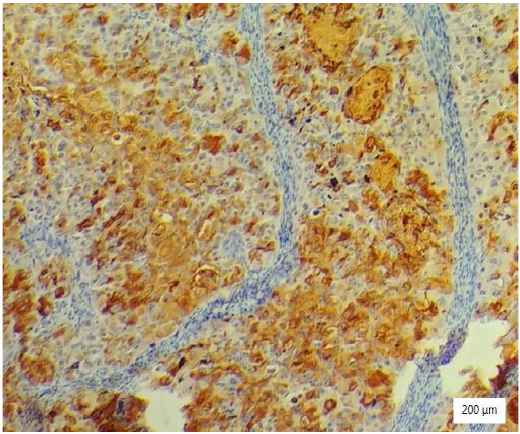
Figure 9. Variable, low expression pattern of P16 in tumor cells (×100). Figure 10. Negative vimentin in tumor cells (×100).